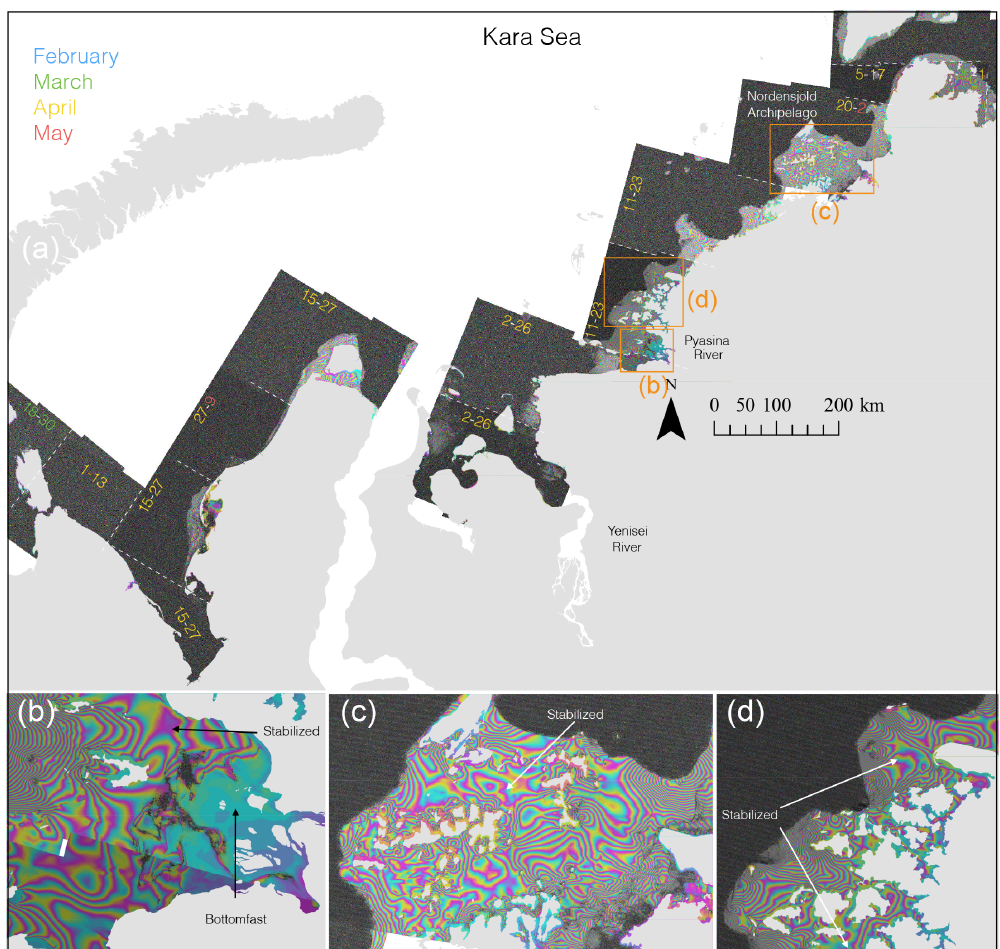
Figure 8. (a) Sentinel-1 interferograms derived from image pairs acquired over the Kara Sea between March and May 2017. Numbers on images represent date ranges. The colors blue, green, yellow, and red signify the months of February–May. (b, c, d) Three enlarged areas identified in (a) are further discussed in the